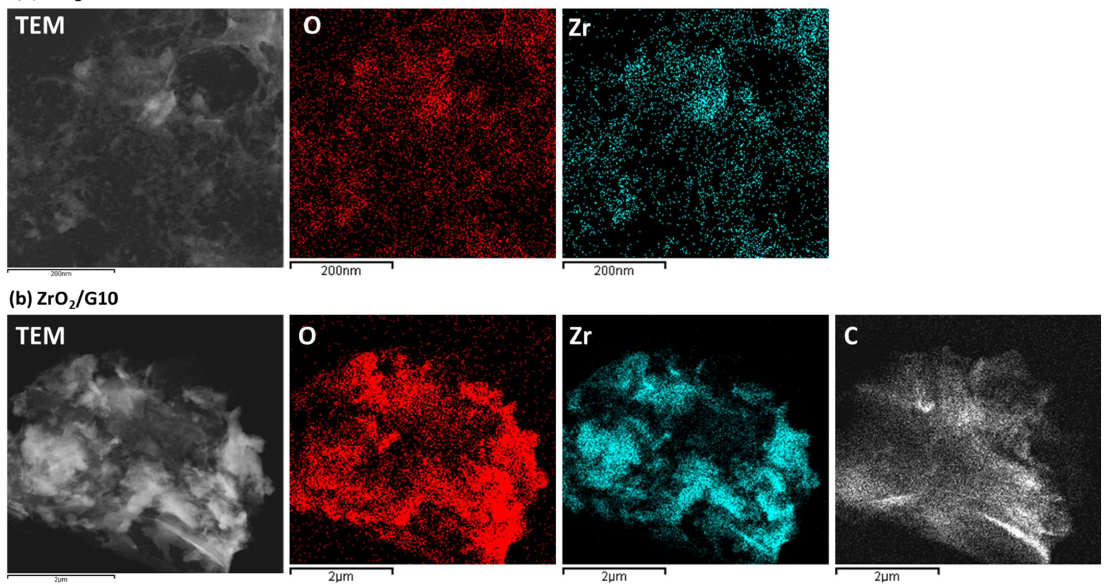
Figure 2. EDX mapping for oxygen, zirconium, and carbon for: ( a ) ZrO 2 , and ( b ) ZrO 2 /G10 samples. On the other hand, regarding the ZrO 2 /G10, the EDX spectrum is shown in Figure 3b. The X-ray energies of Zr, O, and C are indicated on the charts. The element weight percentages of the compound were also calculated and listed in Table 1. The weight percentages of Zr, O, and C elements were 72.16, 18.56, and 9.28, respectively. The result confirms the formation of binary composites as intended in this study. Figure 3. EDX charts for elemental analysis for: ( a ) ZrO 2 and ( b ) ZrO 2 /G10 samples. 2